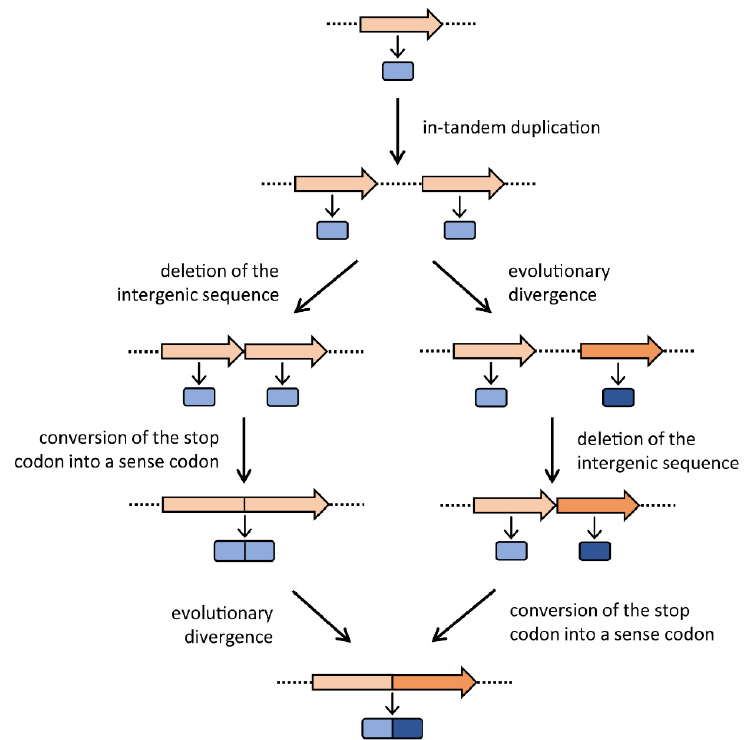
Figure 1. The gene elongation mechanism. The two possible evolutionary routes are depicted. Genes are represented with arrows, and the encoded proteins with rounded rectangles. Representation adapted from Fani and Fondi [3].